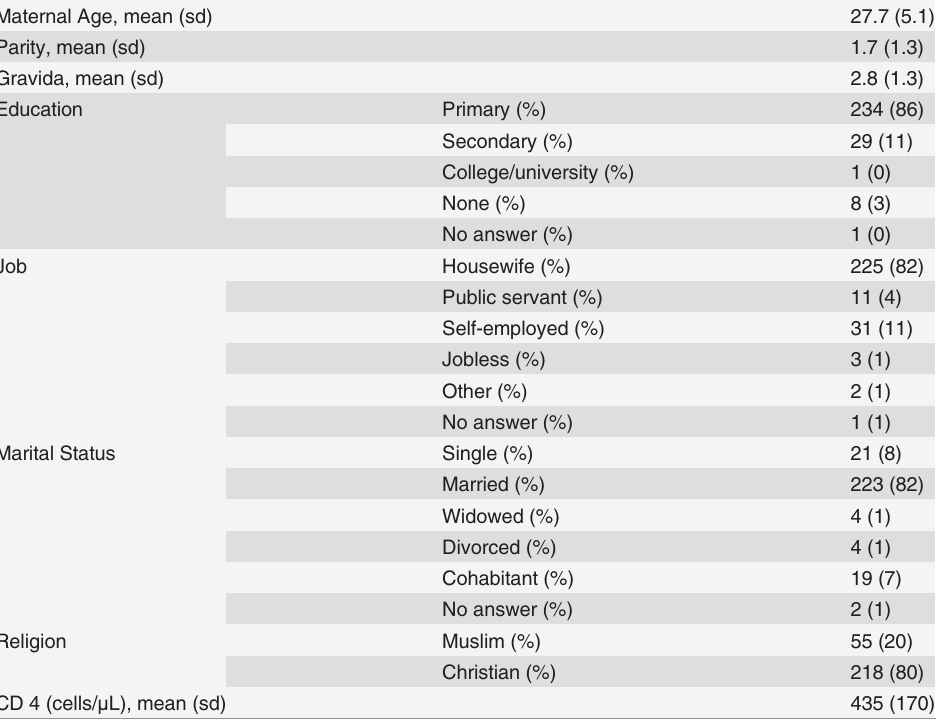
Table 1. Descriptive Characteristics of 273 HIV-Infected